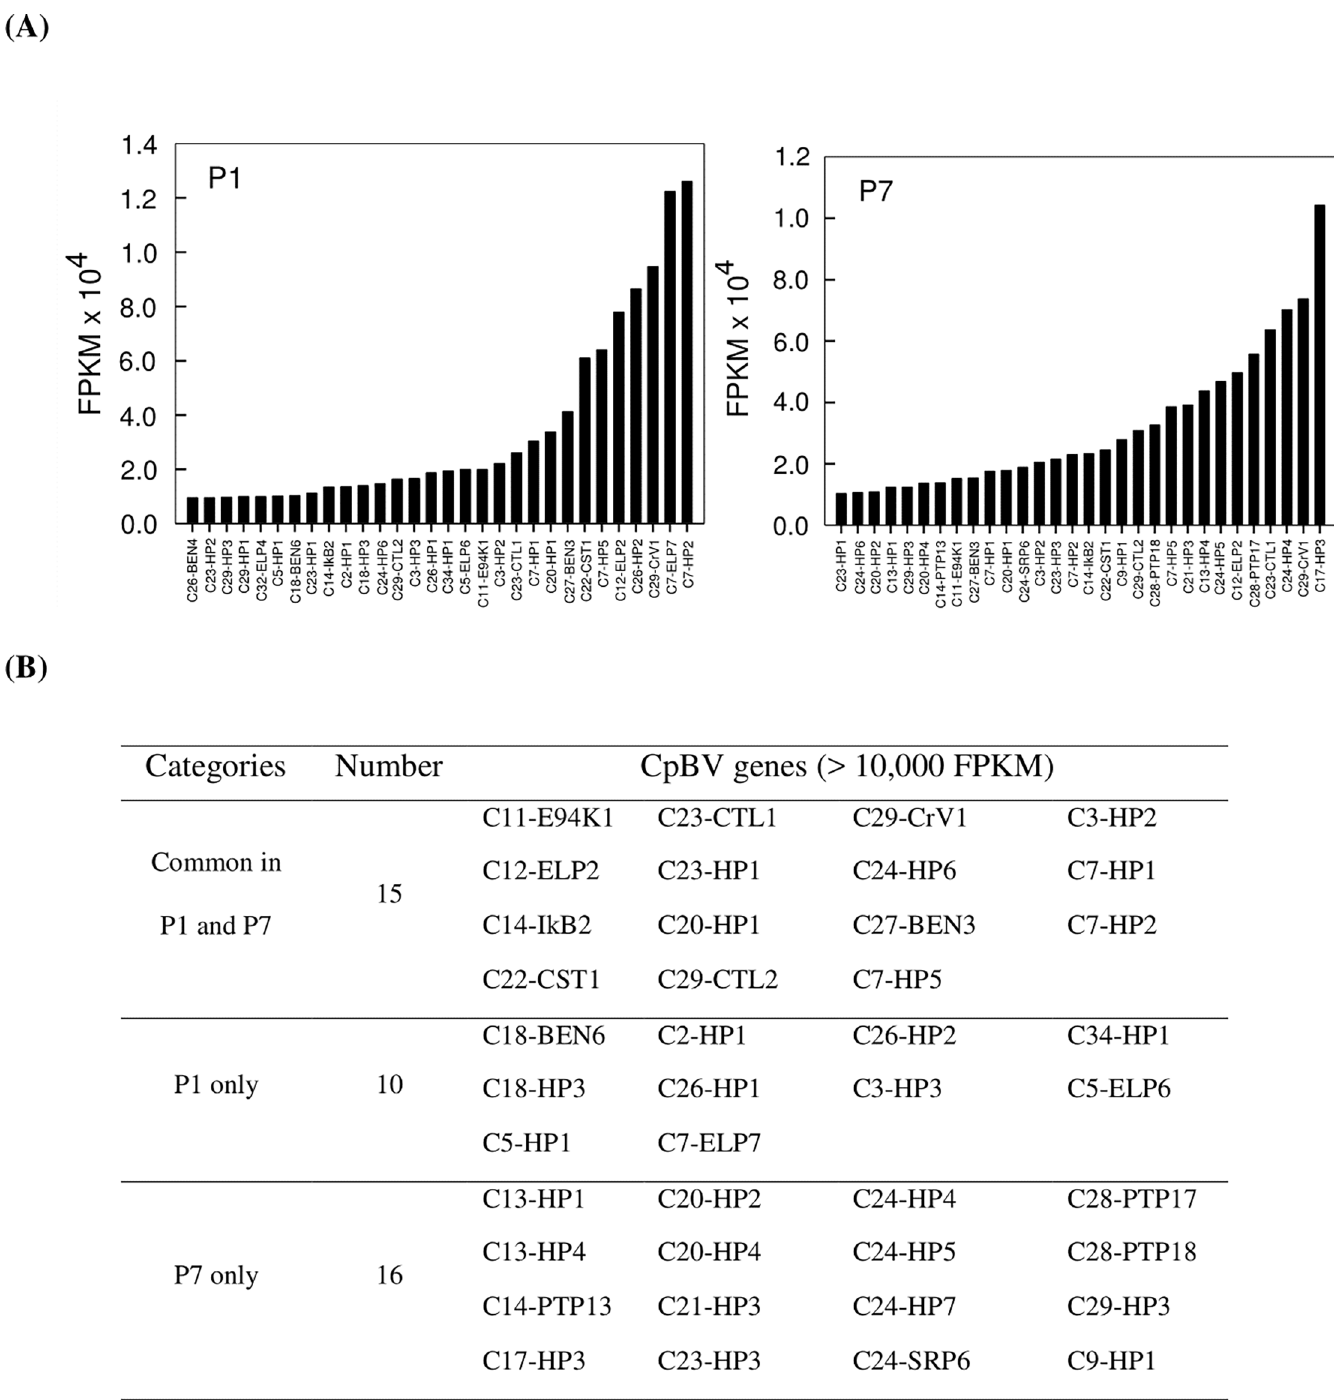
Fig 3. Highly expressed CpBV genes in P . xylostella parasitized by C . plutellae . Expression levels were calculated by FPKM based on read numbers obtained from Illumina HiSeq. (A) Highly expressed CpBV genes at early (one day after parasitization: P1) and late (7 days after parasitization: P7) parasitic stages. (B) Classification of highly expressed genes more than 10,000 scores in FPKM